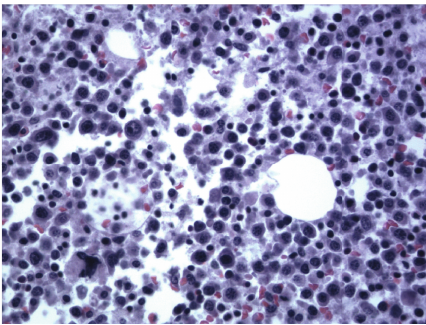
Figure 3: H&E staining of the bone marrow autopsy showing numerous plasma cell (estimated to be more than 10%).